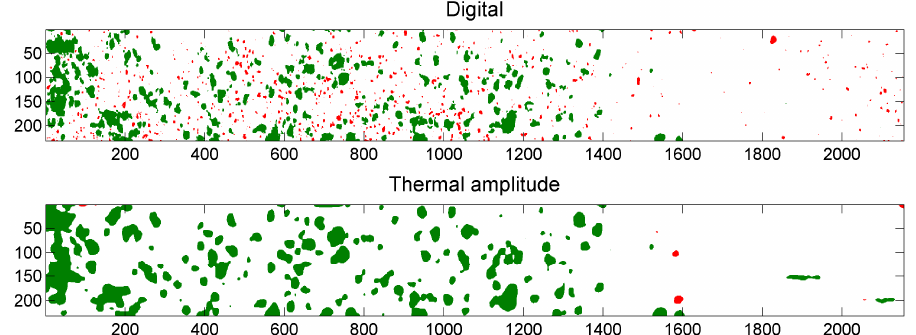
Figure 8. Binarized digital image ( top ); and binarized thermal output image “amplitude” ( bottom ). Coordinates are shown in pixels. Particles that occur in both images are shown in green. Particles that occur only in the digital image or only in the thermal output image are shown in red in respectively the top image and the bottom image.